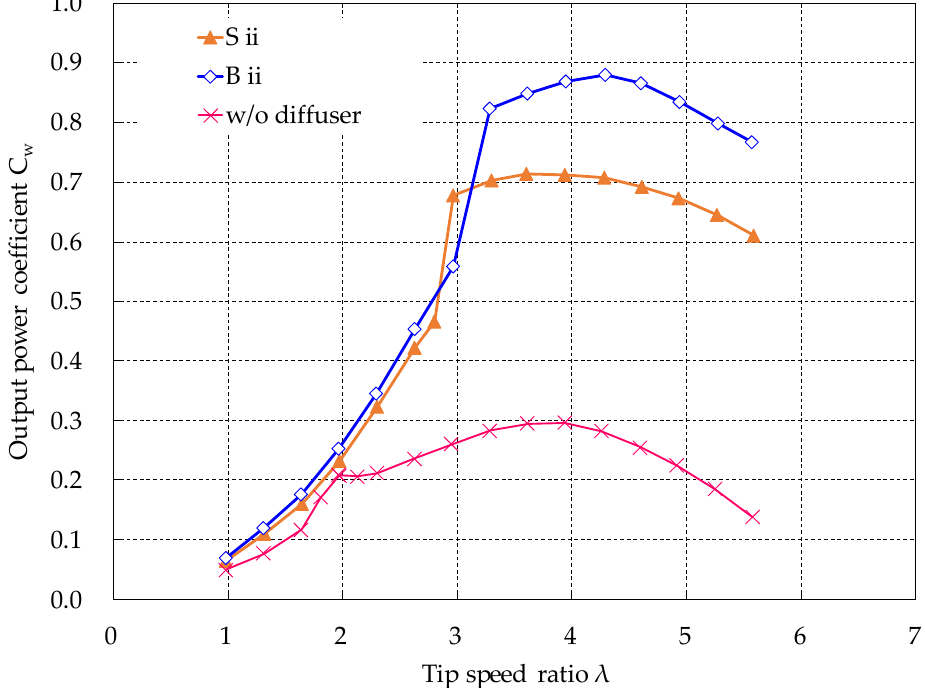
Figure 11. Power curves vs. λ (tip speed ratio) for a wind turbine with compact brimmed diffusers of Sii, Bii and a bare turbine. C w is the output power coefficient.